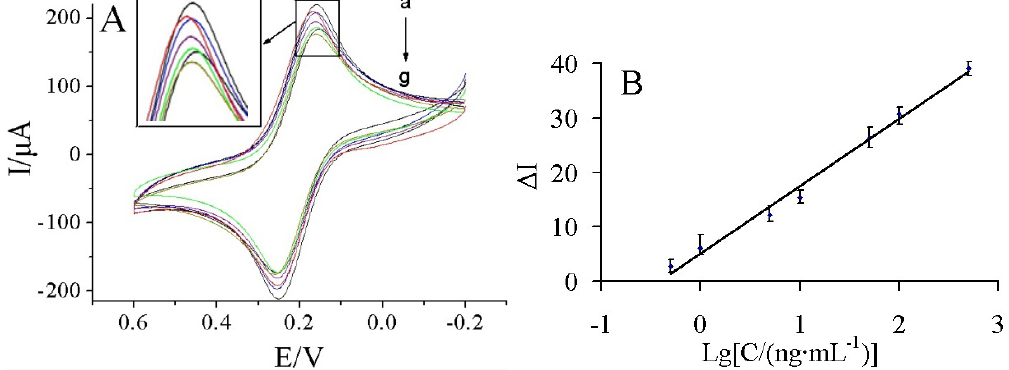
Figure 6. ( A ) The CVs responses of the fabricated immunosensor to the different concentration of carbofuran (from a to g): 0.5, 1, 5, 10, 50, 100, 500 ng/mL under the optimal conditions; ( B ) The calibration curve of the Δ I of the proposed immunosensor vs. the logarithm of carbofuran